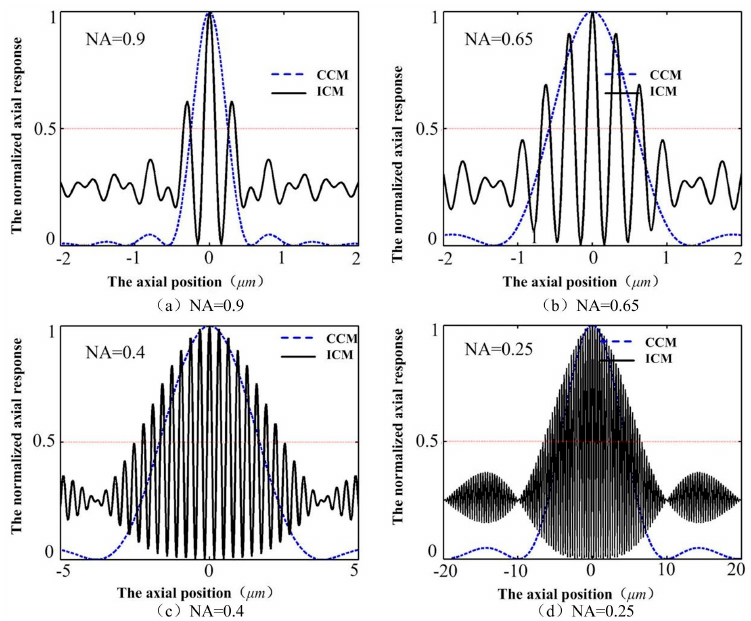
Figure 4. Comparison of normalized axial responses between conventional confocal microscopy (CCM) and Interference confocal microscopy (ICM) using single channel detection with NA = 0.9, 0.65, 0.4, and 0.25, respectively.